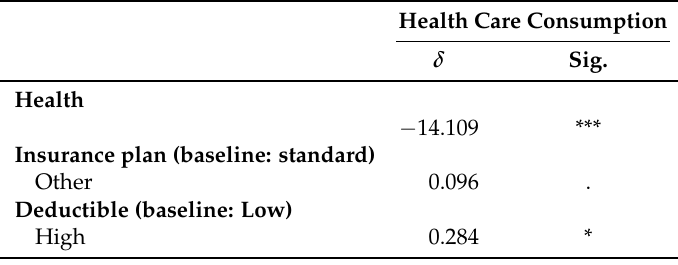
Table 8. Results for the regression model for health care consumption (Equation